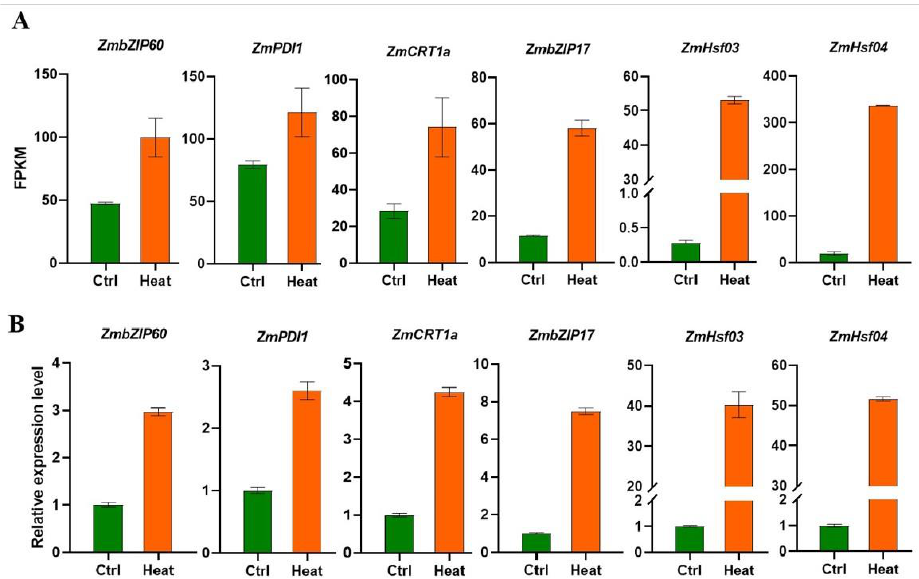
Figure 3. Validation of DEGs by quantitative real-time PCR: ( A ) FPKM values of six genes from RNAseq data; and ( B ) qRT-PCR validation of gene expression.